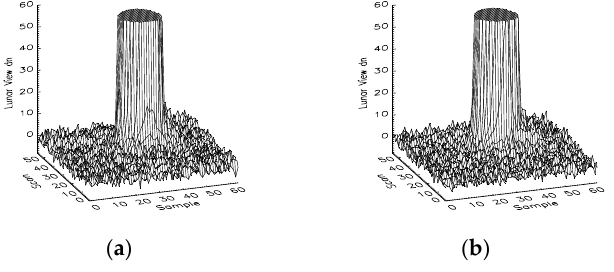
Figure 5. Lunar images observed by the SNPP VIIRS thermal emissive band I5 on 2 April 2012: ( a ) detector 16 and ( b ) detector 17.